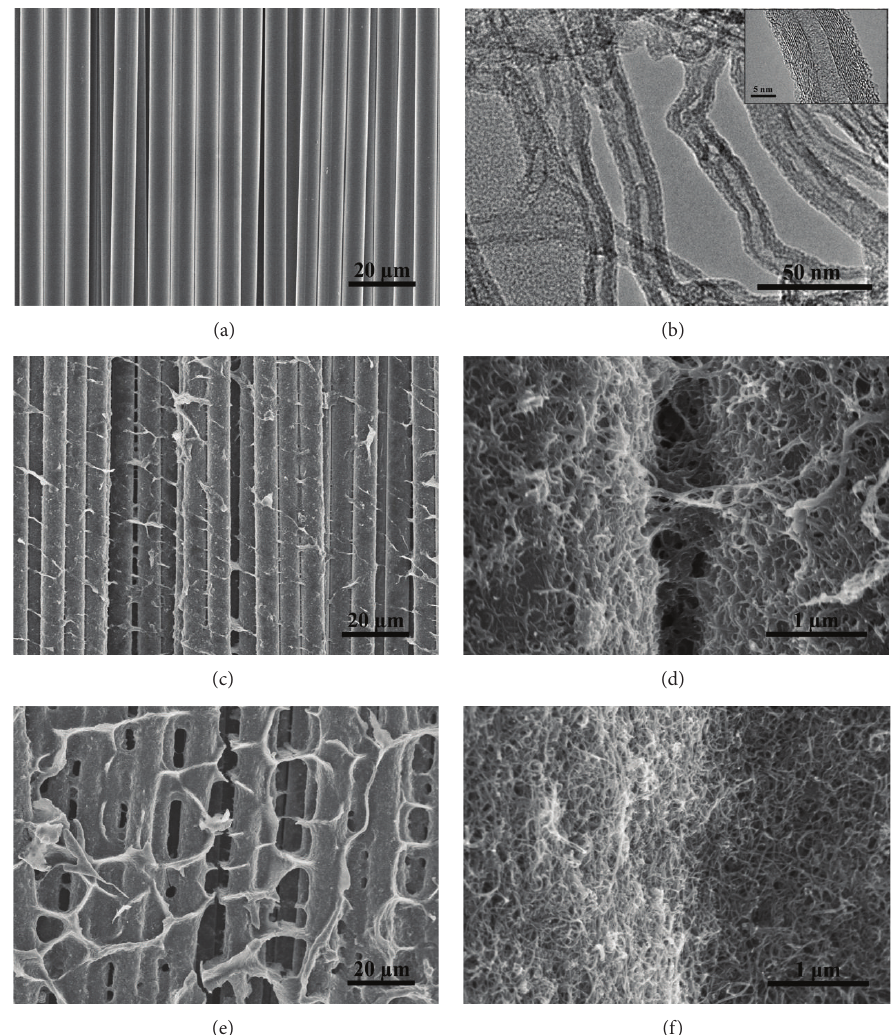
Figure 1: (a) SEM micrograph of as-received carbon fibers, (b) TEM image of pristine multiwalled CNTs, (c) SEM image of the distribution of CNTs in the preform with the CNT content of 1wt%, (d) SEM image of CNT networks of 1wt% between fibers in one fiber bundle, (e) the distribution of CNTs in the preform with the CNT content of 2.5 wt%, and (f) SEM image of CNT networks of 2.5 wt% between fibers in one fiber